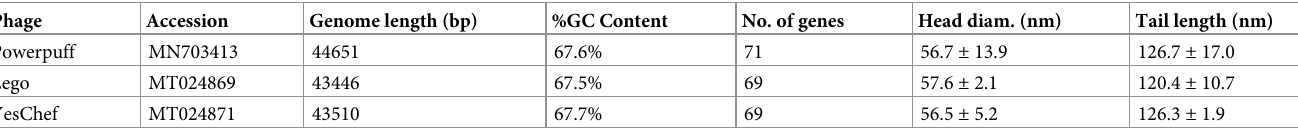
Table 1. Phages Powerpuff, Lego, and YesChef share similar genomic and physical